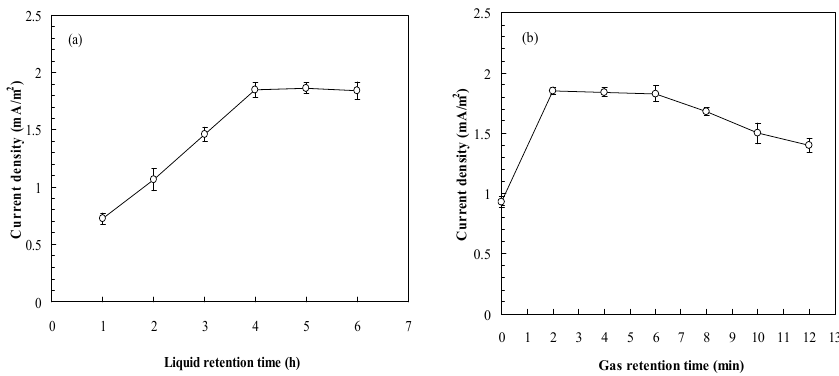
Figure 1. Effects of ( a ) Liquid retention time (GRT: 6 min); ( b ) Gas retention time (LRT: 4 h) on the MFC performance (GGA concentration: 100 mg/L as BOD 5 ).